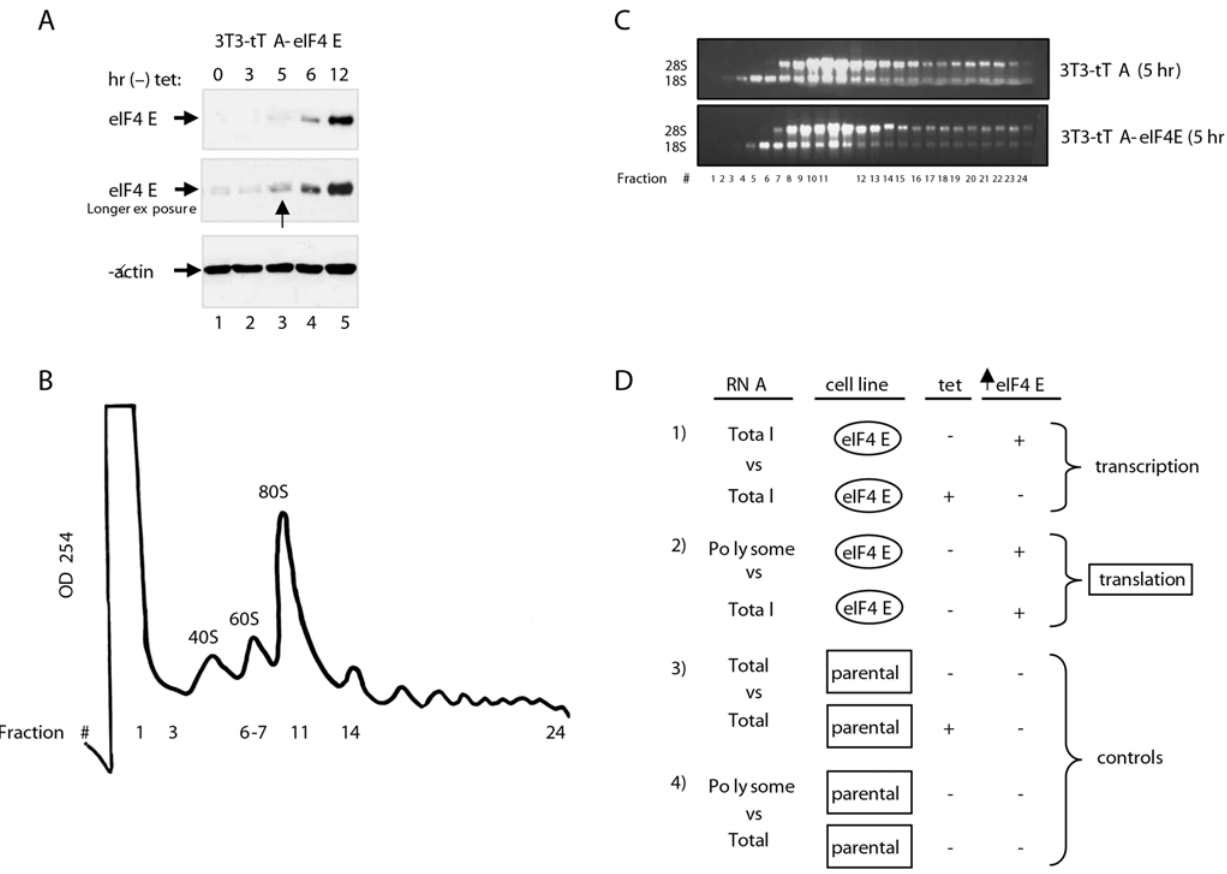
Figure 1. Induction of eIF4E in NIH 3T3 fibroblast cells and microarray analysis. A) eIF4E overexpression was induced by culturing 3T3-tTA-eIF4E cells in a tetracycline free medium. Immunoblots for eIF4E and b -actin were performed. B) A characteristic fractionation profile of 3T3-tTA and 3T3- tTA-eIF4E cells is depicted. Absorbance at 254 nm was monitored. C) Fractions from 3T3-tTA and 3T3-tTA-eIF4E (induced) cells were analyzed on a denaturing agarose gel to visualize the 18S and 28S rRNAs. D) The experimental design used for microarray analysis is shown.